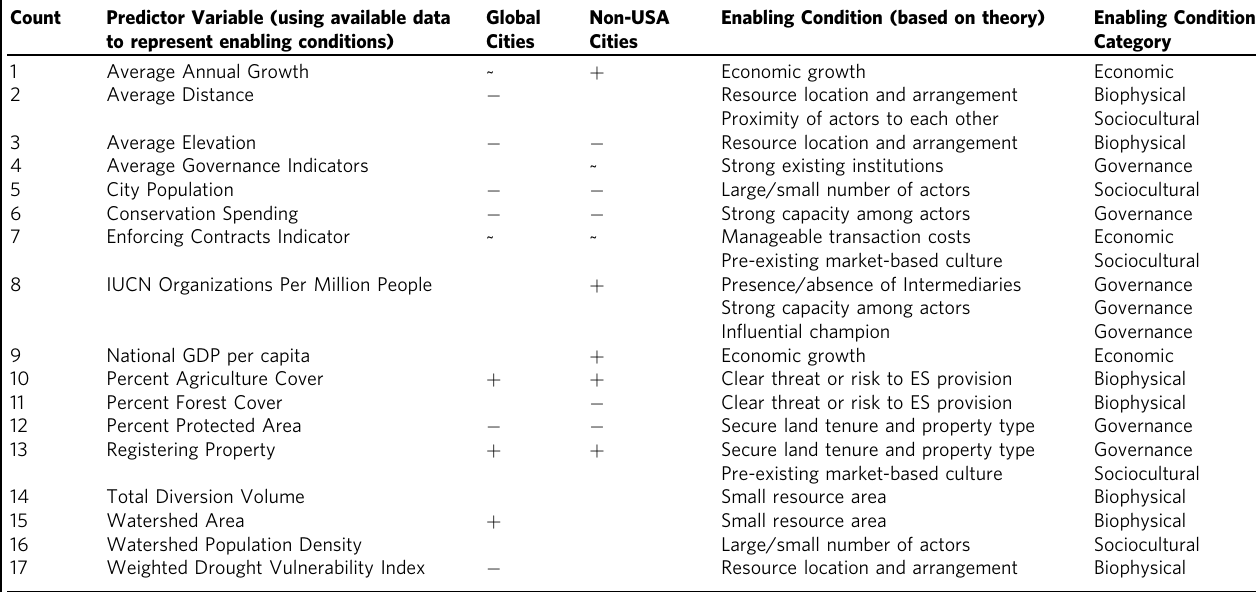
Table 1 Enabling conditions variables analyzed and their relationships with IWS Count Predictor Variable (using available data to represent enabling